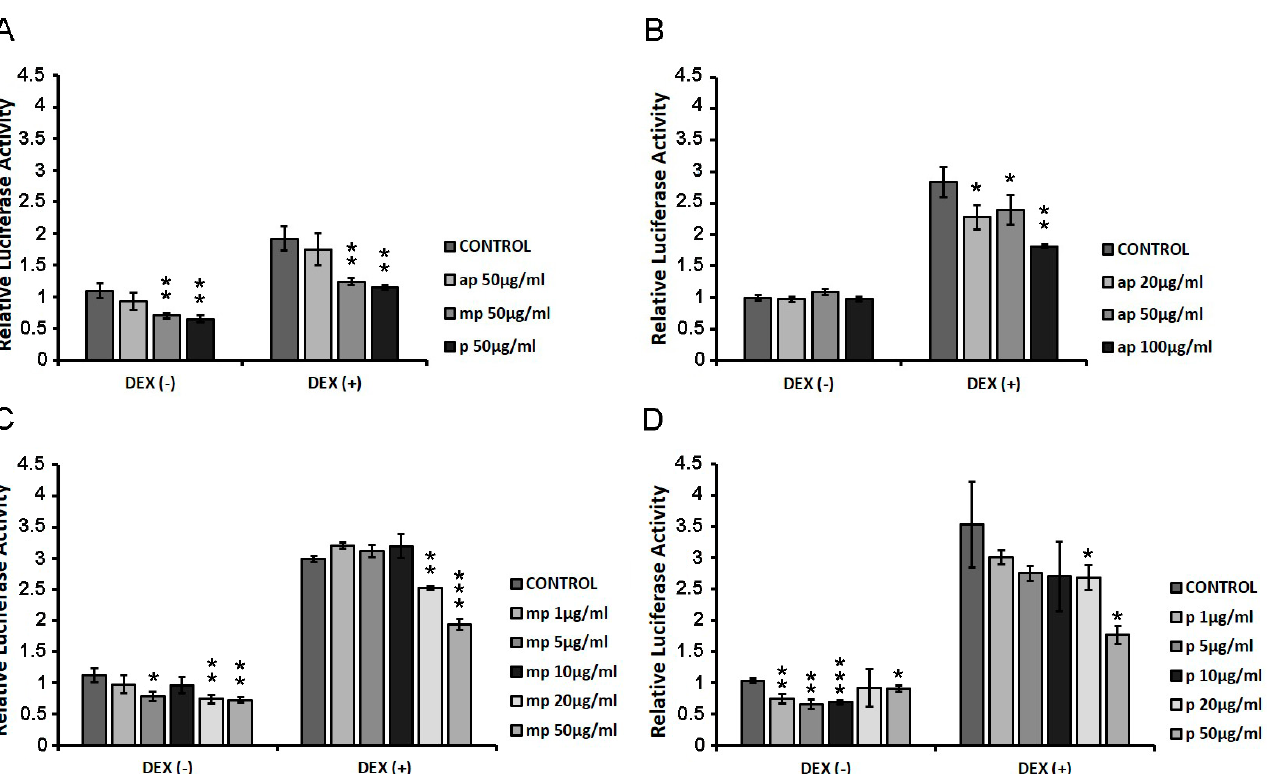
Figure 3. Suppression of the DEX-induced GR transcriptional activation by the Chios Mastiha different polarity fractions. Luciferase and β -galactosidase enzymatic activity was evaluated in extracts from HEK293 cells cultured in the absence of hormones, transiently co-transfected with a GREs-Luc reporter gene construct and a β -galactosidase reporter construct, and subsequently subjected to treatment with ( A ) 50 µ g/mL apolar (ap), medium-polar (mp), and polar (p) Mastiha fractions ( B ) 20–100 µ g/mL apolar (ap) Mastiha fraction, ( C ) 1–50 µ g/mL medium-polar (mp) Mastiha fraction, and ( D ) 1–100 µ g/mL polar (p) Mastiha fraction and/or 1 µ M DEX, for 6 h. DMSO (1:1000) and EtOH (1:1000) were added in control condition. Relative luciferase activity results from normalization of the luciferase activity to β -galactosidase activity. Relative luciferase activity of control cells was set as 1. Data are expressed as the mean ± SD, (n = 2–3), * p < 0.05; ** p < 0.01; *** p < 0.001.